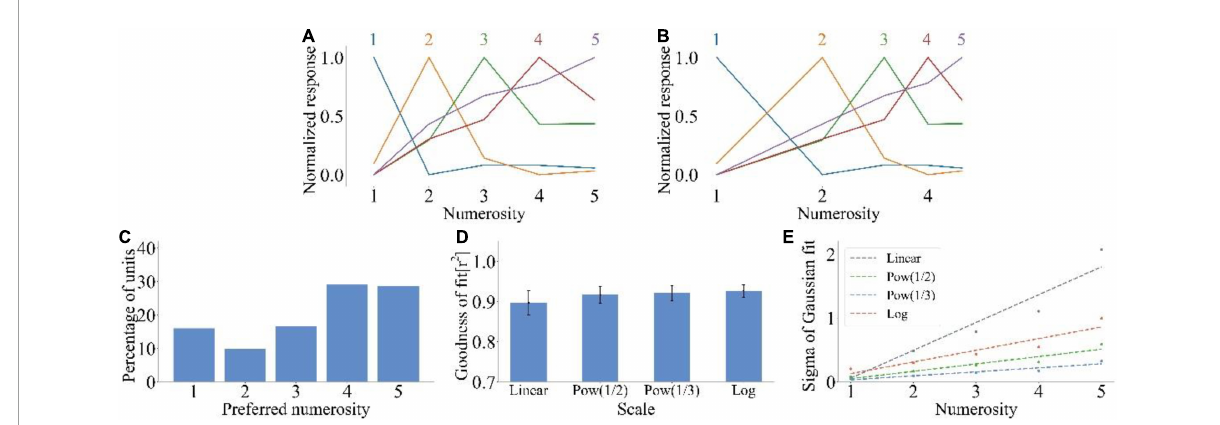
FIGURE2 Output response of spike neural network model under non-symbolic numerosity dataset. (A) Average tuning curves for network units that prefer each non-symbolic numerosity plotted on a linear scale. The horizontal axis is the numerosity in the image, and the vertical axis is the average response after normalization. (B) Average tuning curves for network units that prefer each non-symbolic numerosity plotted on a logarithmic scale. The horizontal axis is the numerosity in the image and plotted on a logarithmic scale of f ( x ) = log 2 ( x ) . (C) Distribution of preferred numerosities of numerosity-selective network units. The horizontal axis is the numerosity, and the vertical axis is the proportion of the number of units that prefer a specific numerosity in the total number of units. (D) Average goodness-of-fit measure for fitting Gaussian functions to tuning curves on different scales. The average response curves with the preferred numerosity ranging from 1 to 5 were combined via Gaussian fitting, and the goodness of fit was calculated using the four scales ( f ( x ) = x , f ( x ) = x 1 2 , f ( x ) = x 1 3 , f ( x ) = log 2 ( x )) . (E) Standard deviation of the Gaussian function with an optimal fit for each tuning curve of numerosity-selective network units on different scales. The horizontal axis is the preferred numerosity, and the vertical axis is the standard deviation.